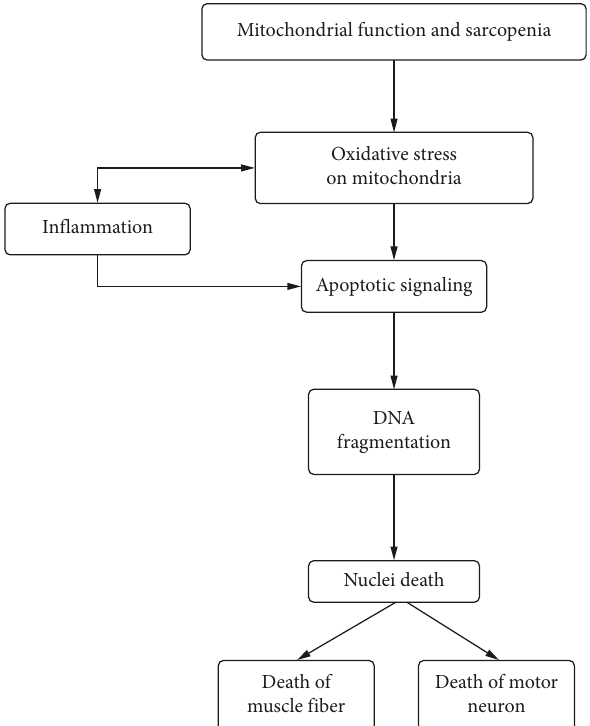
Figure 2: Model for hypothesis that oxidative stress and chronic inflammation influence muscle